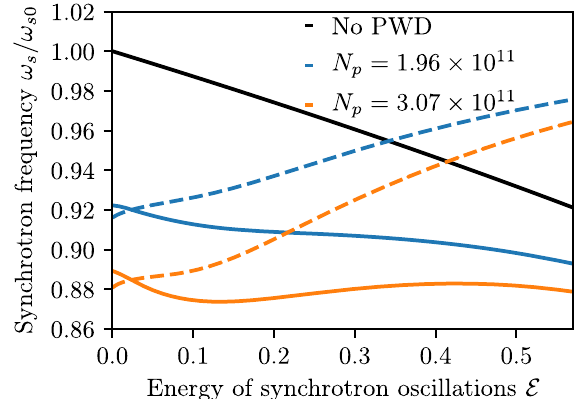
FIG. 7. Real (solid lines) and imaginary (dashed lines) parts of van Kampen modes as functions of bunch intensity for ¼ 0 . 57 . Solid E ¼ 0 . 57 , neglecting rf nonlinearity and max max